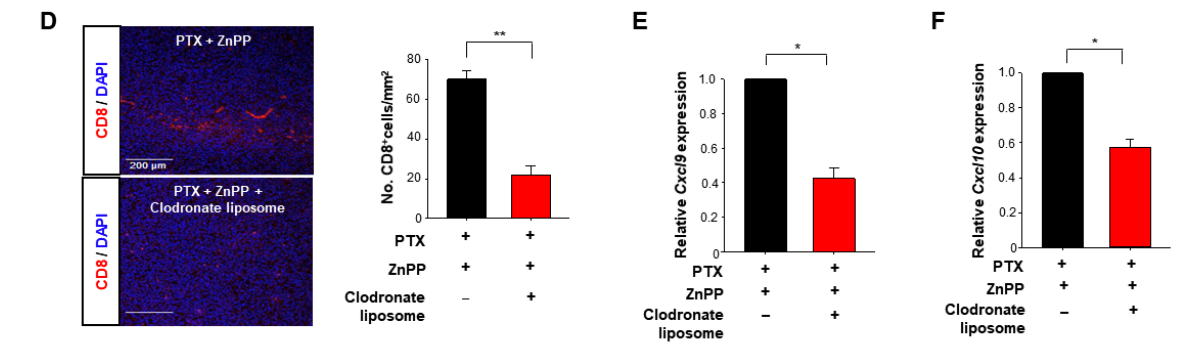
Figure 7. Attenuation of anti-tumor activity of PTX plus an HO-1 inhibitor by macrophage depletion in a murine syngeneic breast tumor model. ( A ) Macrophage depletion was confirmed by flow cytometry. ( B ) 4T1 breast cancer-bearing mice were injected with vehicle or PTX (5 mg/kg, 5 days) in combination with daily intraperitoneal injection of ZnPP (40 mg/kg). For macrophage depletion, mice were treated with clodronate liposomes 3 times at 4-day intervals as described in Materials and Methods. Representative photographs of tumors are shown for each group. ( C ) Tumor volume was calculated as a relative change and plotted as the mean ± SEM. ( D ) Representative images of tumor sections stained for CD8 + T cells and DAPI are shown. ( E , F ) The whole-tumor mRNA expression levels of Cxcl9 and Cxcl10 were analyzed by qPCR. *, **, *** Significantly different between groups compared (* p < 0.05; ** p < 0.01, *** p < 0.001).